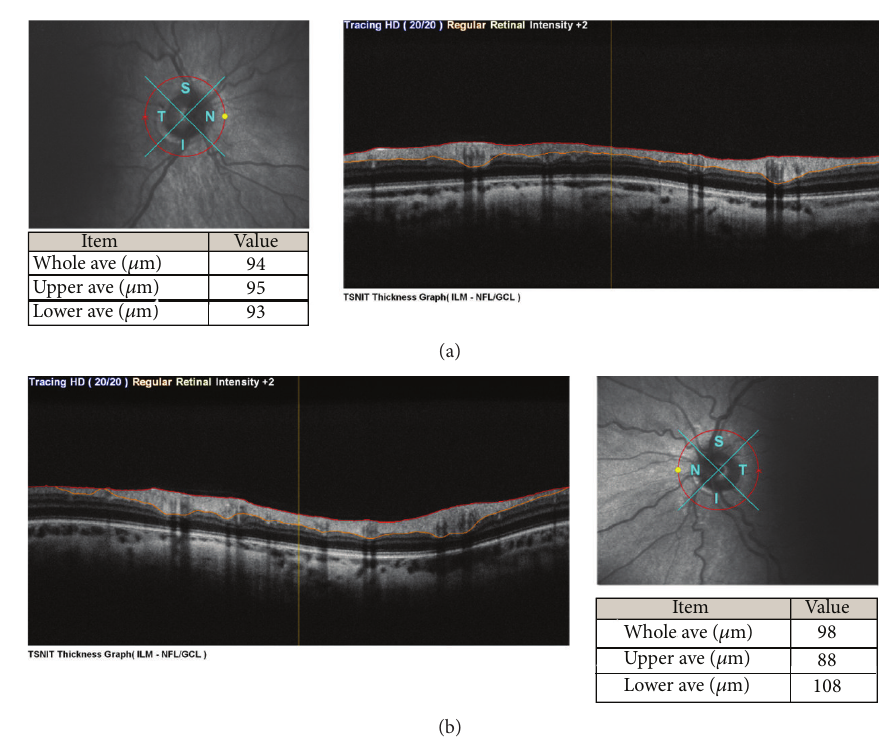
Figure 6: Optic disc measurements were within normal limits in the right eye (a) and in the left eye (b).